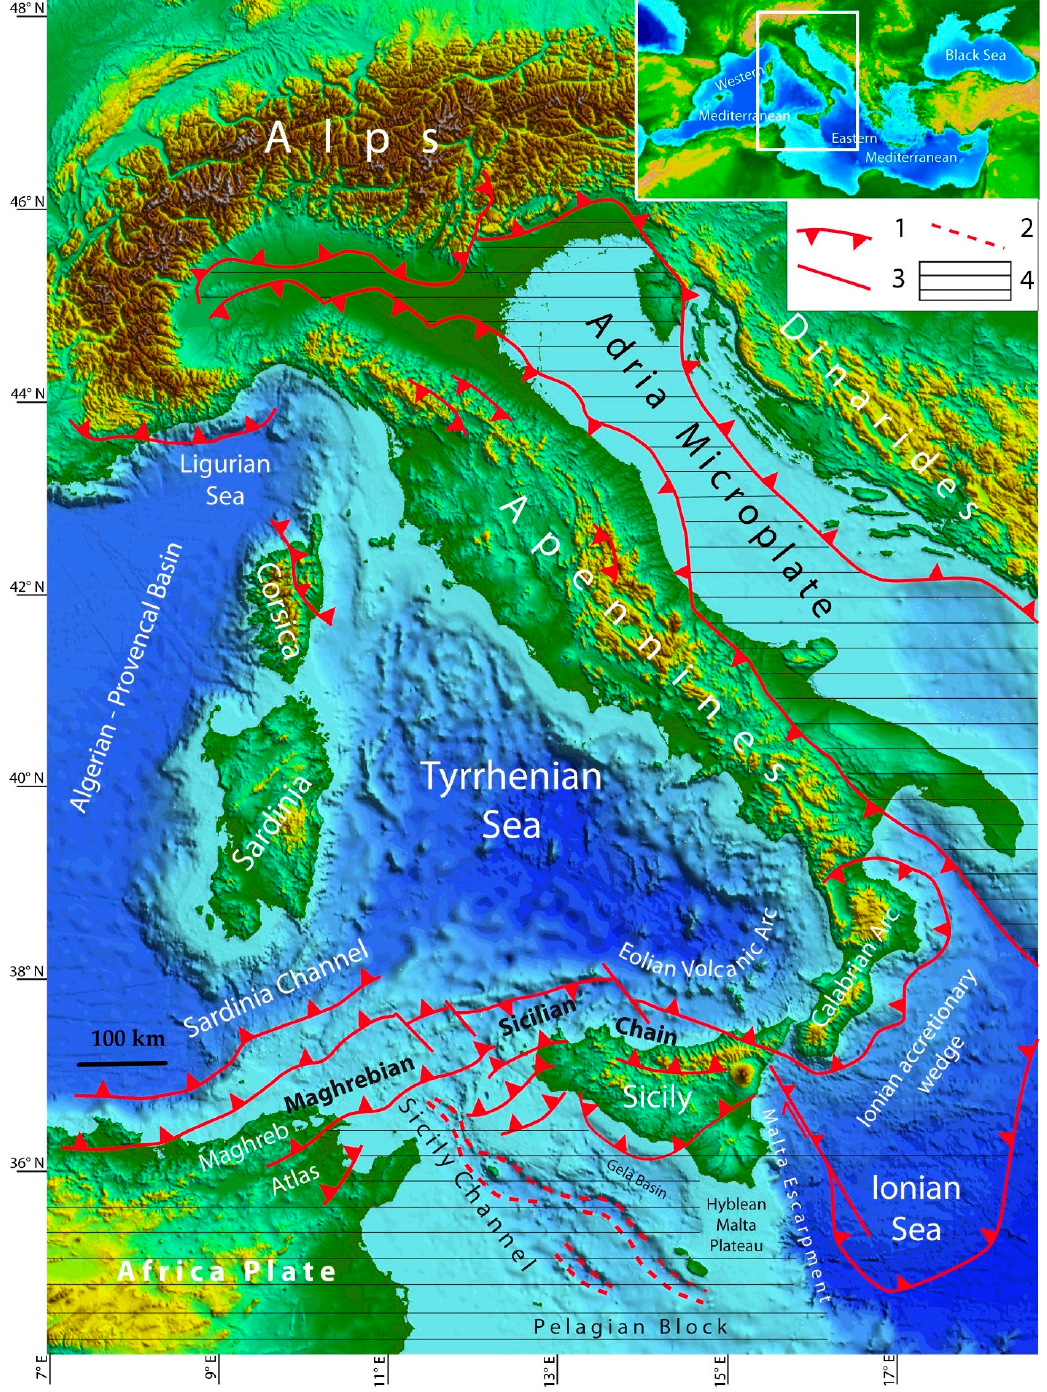
Figure 2. Simplified structural map of the central Mediterranean Sea, showing the main tectonic structures related to the Ionian subduction system. Colour relief is derived from data downloaded from GEBCO gridded bathymetry ([40]). Structural features are summarized in [41] (for the Italian Peninsula and Adriatic Sea sectors) and [42] (for the Sardinian Channel and Strait of Sicily sectors). The inset in the top right corner